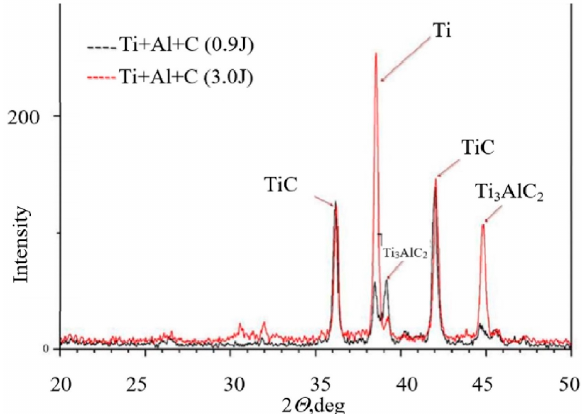
Figure 7. X-ray diffraction pattern of the coating on Cr18Ni10T steel, obtained by successive treatment with titanium, aluminum, and graphite electrodes and their powders.